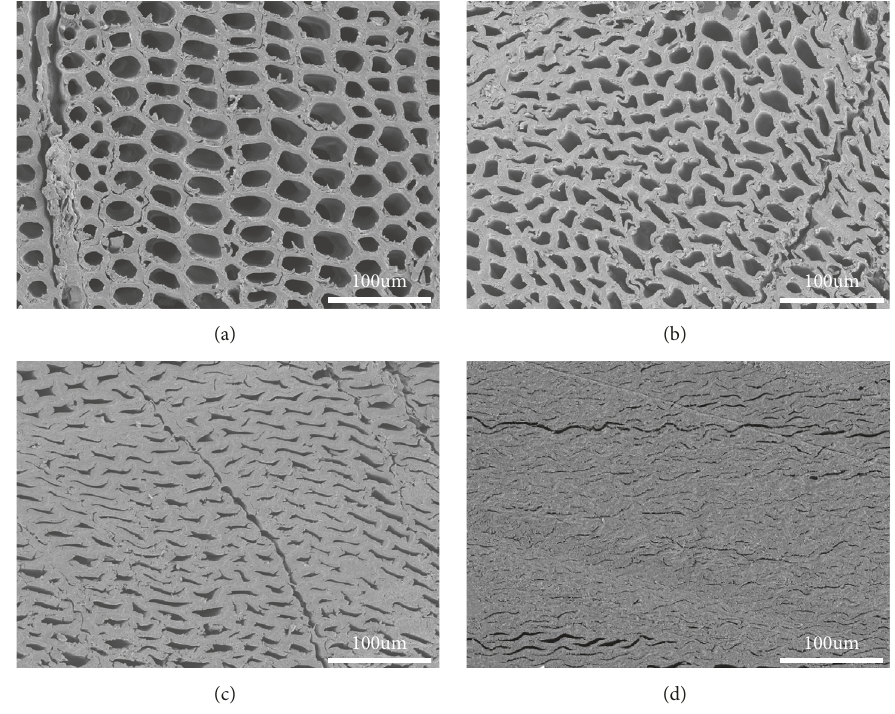
Figure 3: SEM micrographs of scrimbers with density of (a) 0.80, (b) 1.01, (c) 1.20, and (d) 1.39 g cm −3